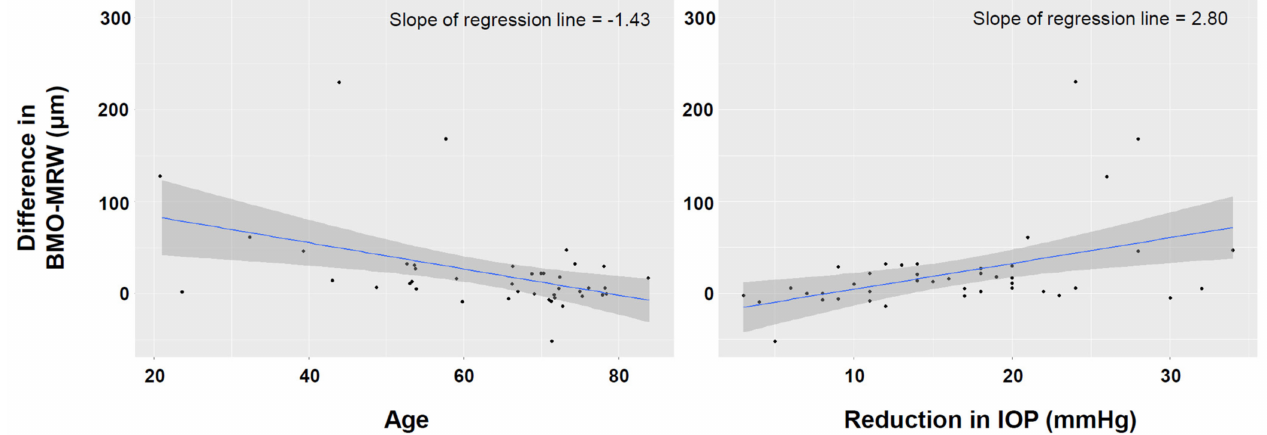
Figure 1. Scatter plot showing the relationship between the increase in the Bruch’s membrane opening-minimum rim width (BMO-MRW) after trabeculectomy and the patients’ age (left) and the amount of IOP reduction after trabeculectomy